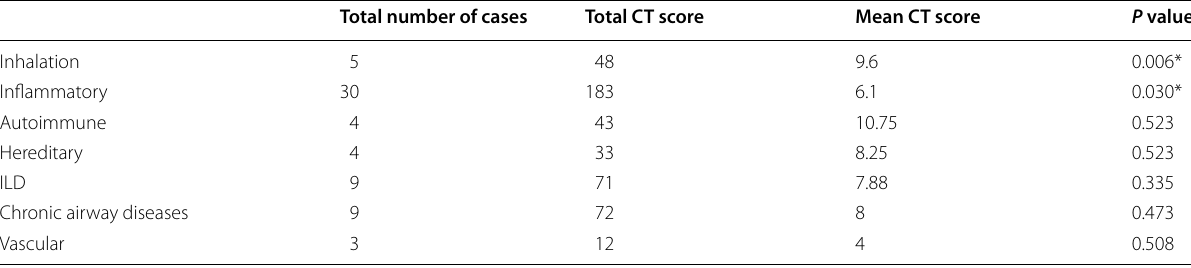
ILD Interstitial lung disease,